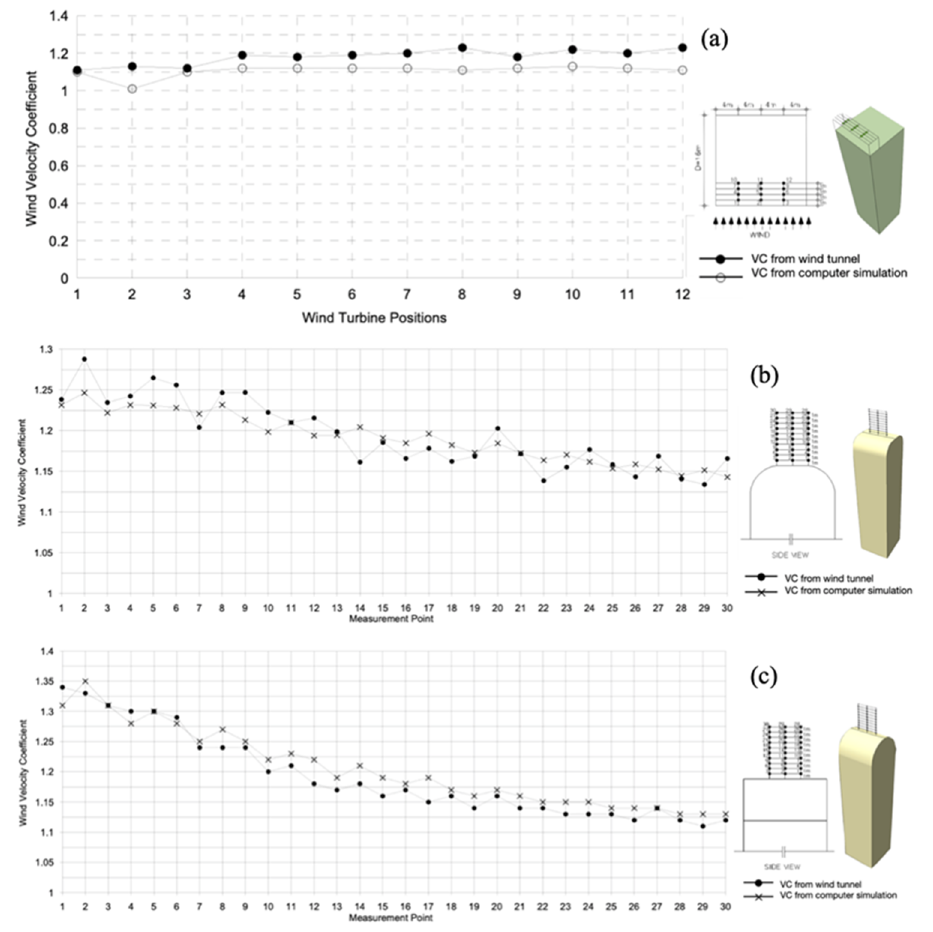
Figure 12. Velocity coefficient (VC) results from wind tunnel experiment and computer simulation on ( a ) building A, ( b ) building B, ( c ) building C. Overall the wind flow patterns were similar and the VC were similar.